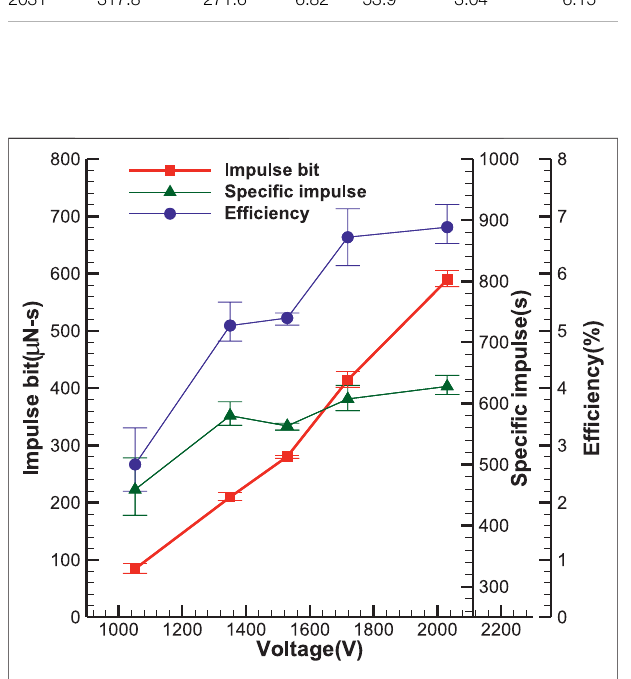
FIGURE 4 | APPT thruster performances at different initial voltages.